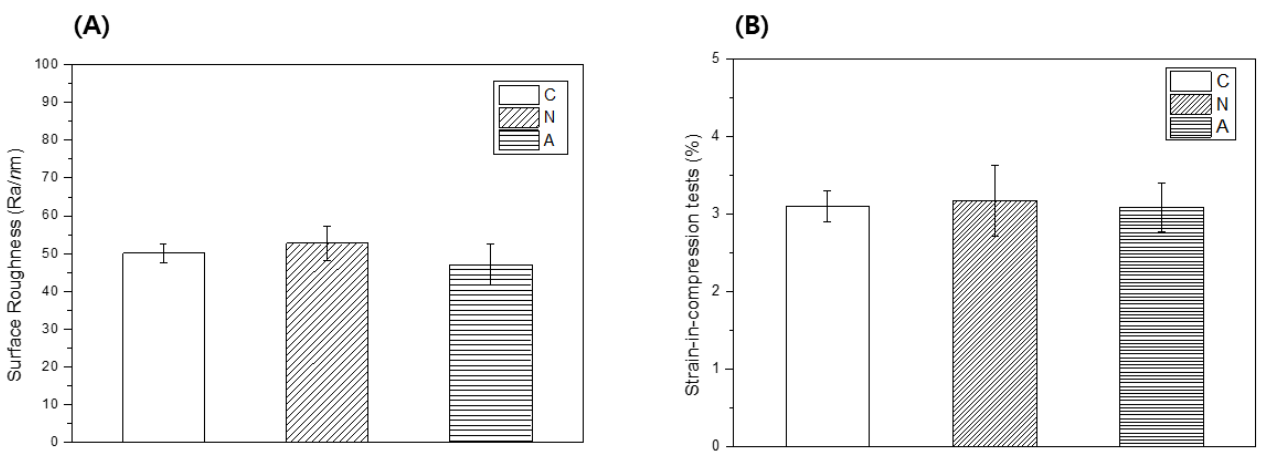
Figure 6. Result of physical properties ( A ) surface roughness of each polyvinyl siloxane impression surface. ( B ) strain ‐ in ‐ compression tests measurement results (%). C: control (nontreated) group, N: nitrogen ‐ plasma ‐ treated group, and A: air ‐ plasma ‐ treated group.